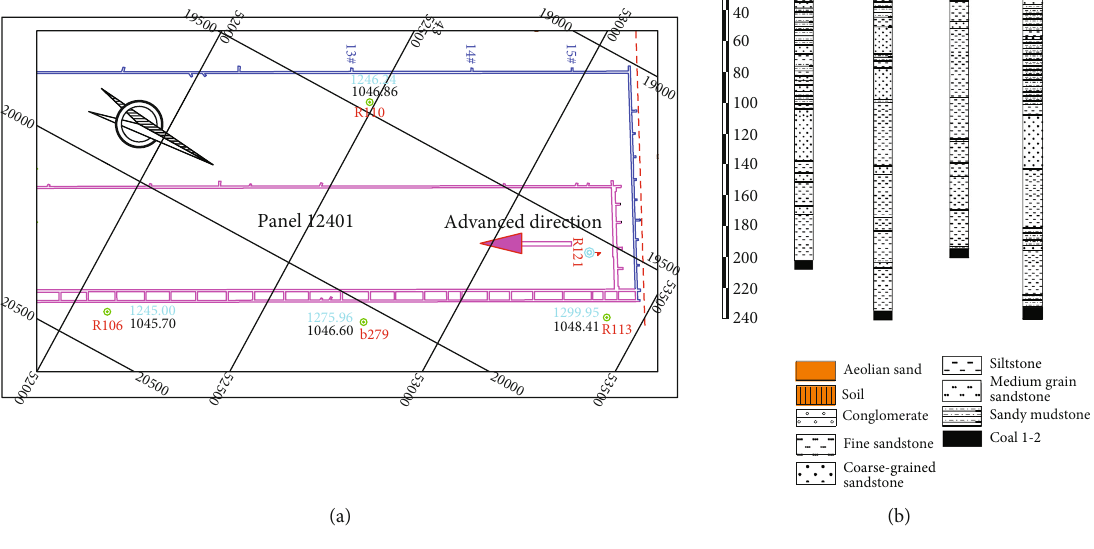
Figure 1: Working face and histogram.